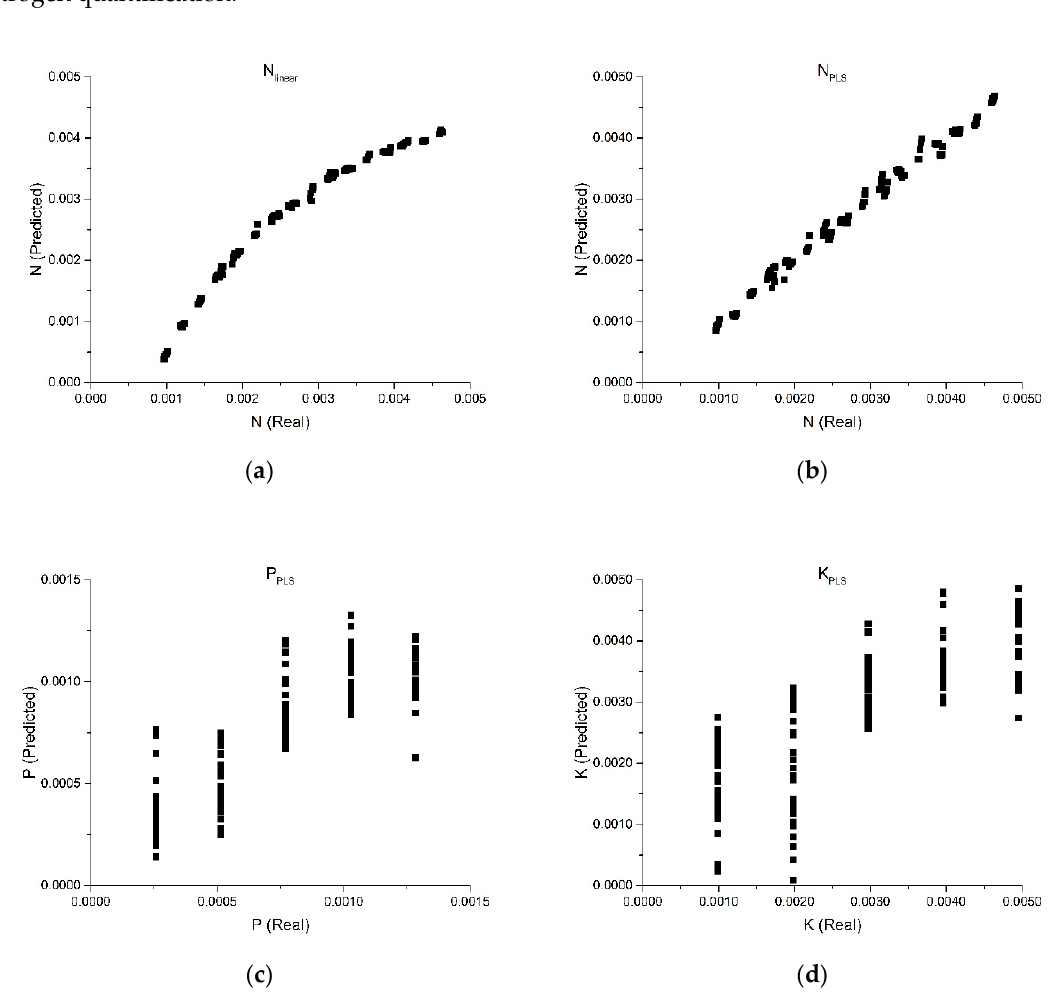
Figure 7. Total nitrogen quantification prediction using a linear model ( a ); optimized PLS-R model for quantifying total nitrogen ( b ), phosphorus ( c ) and potassium ( d ).